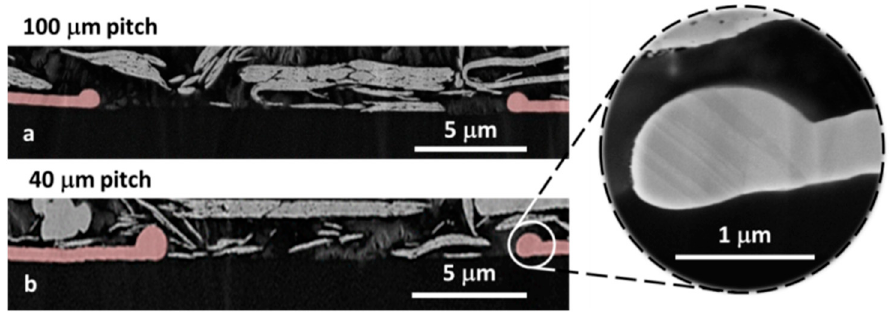
Figure 7. Red, color-enhanced, cross-sectional images of dewetted ridges of Ag for ( a ) 100 µ m and ( b ) 40 µ m pitched arrays. The right and left sides of two adjacent digits are shown.